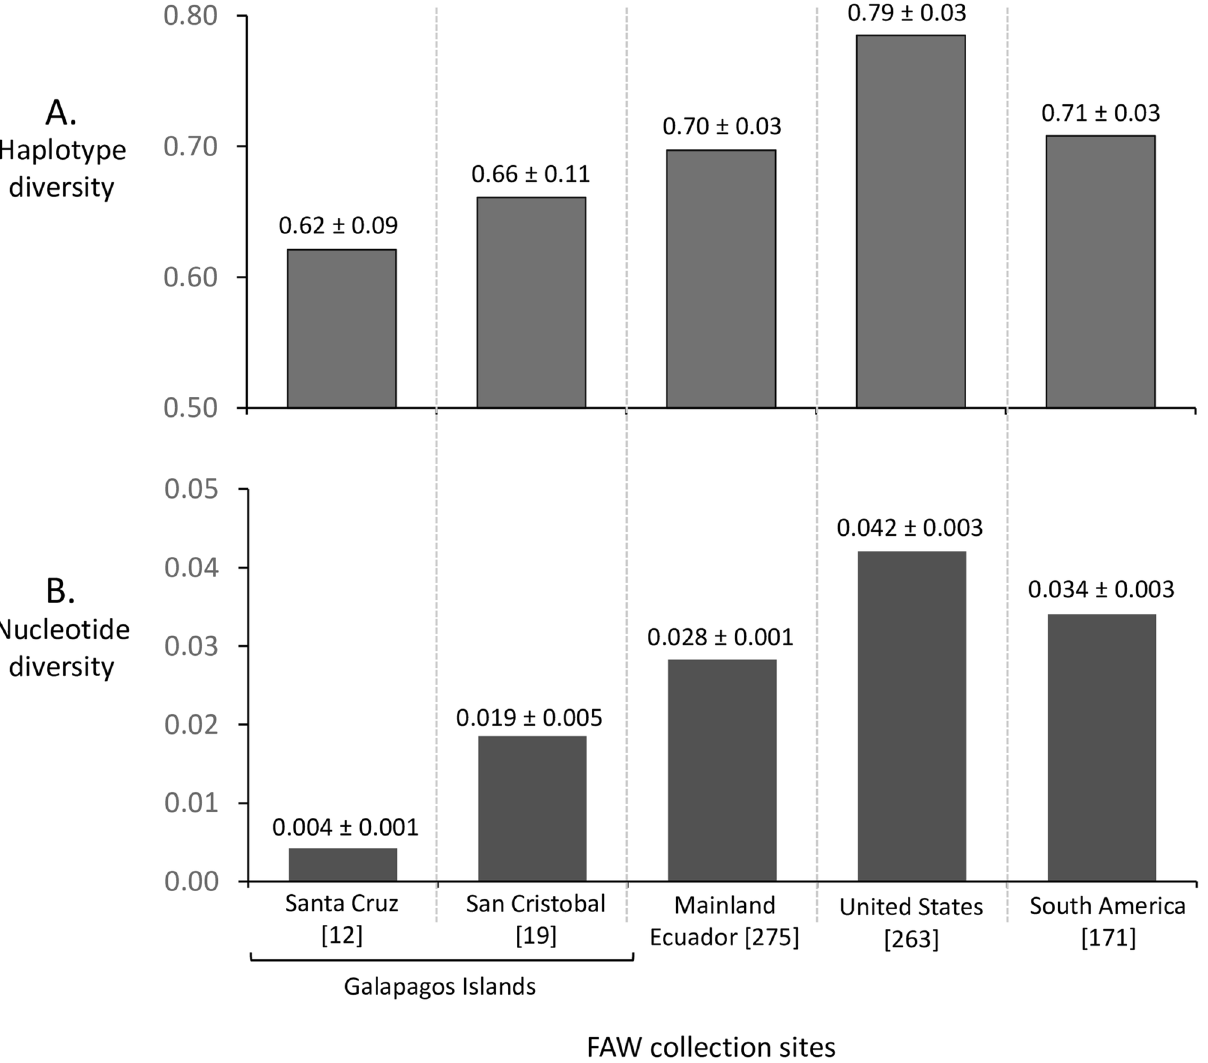
Figure 6. Measurements of genetic variation between select locations in Ecuador and the rest of the Western Hemisphere. ( A ) Haplotype diversity calculations (± standard deviation). ( B ) Nucleotide diversity metric (± standard deviation). Numbers in parentheses indicate sequences